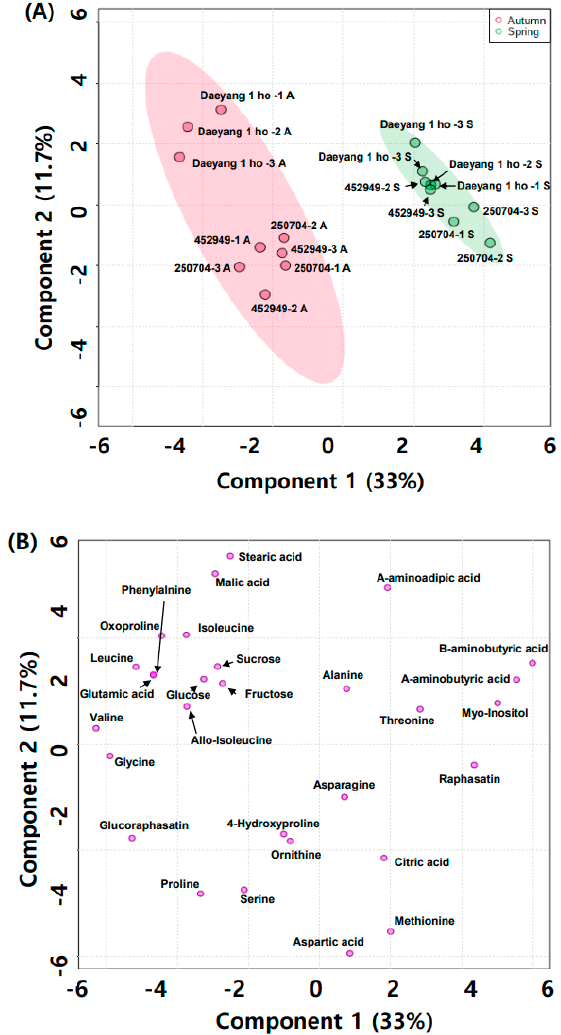
Figure 4. ( A ) Partial least squares discriminant analysis (PLS-DA) score plot; and ( B ) loading plot derived from GC-MS season and cultivar data.